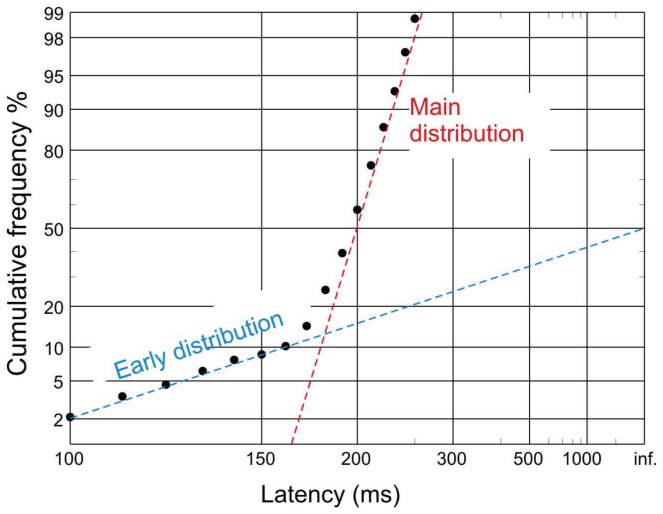
Reciprobit plot of saccade latencies from a healthy volunteer.Cumulative probability is plotted on the y axis on a probit scale. Using this scale, plotting a normal distribution results in a straight line. Latency is plotted on the x axis using a reciprocal scale. The reciprocals of the latencies are equally spaced along this scale. Additionally this scale is mirrored, so that short latencies are to the left and long to the right: infinite latencies, whose reciprocals are zero, therefore form the right hand margin. Because their reciprocal latencies are normally distributed, with mean mu and standard deviation sigma, most latencies lie on a straight line (red), the main distribution, whose median and slope correspond to mu and sigma. In addition, under some conditions there may be a sub-population of early saccades (blue) that lie on a line of shallower slope, corresponding to a third parameter early sigma.